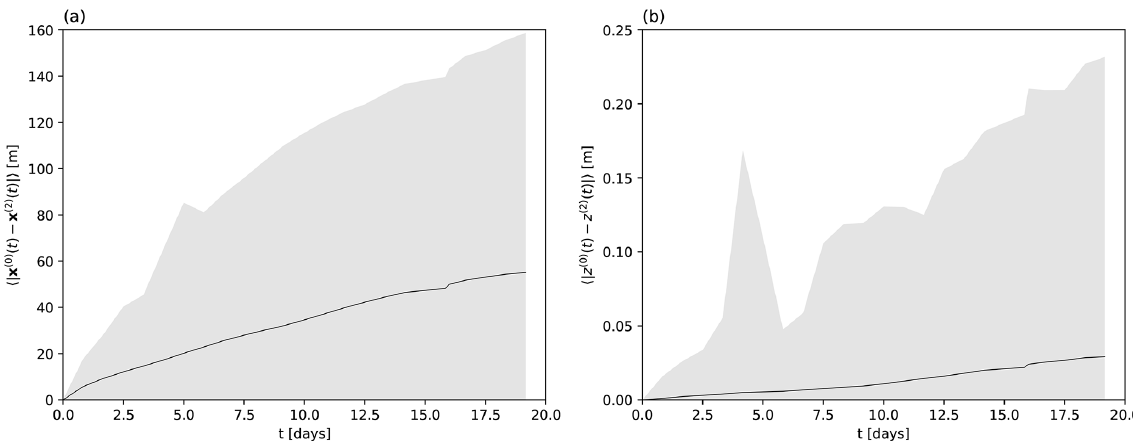
(a) and the average vertical distance d I v (b) of particles released from the h